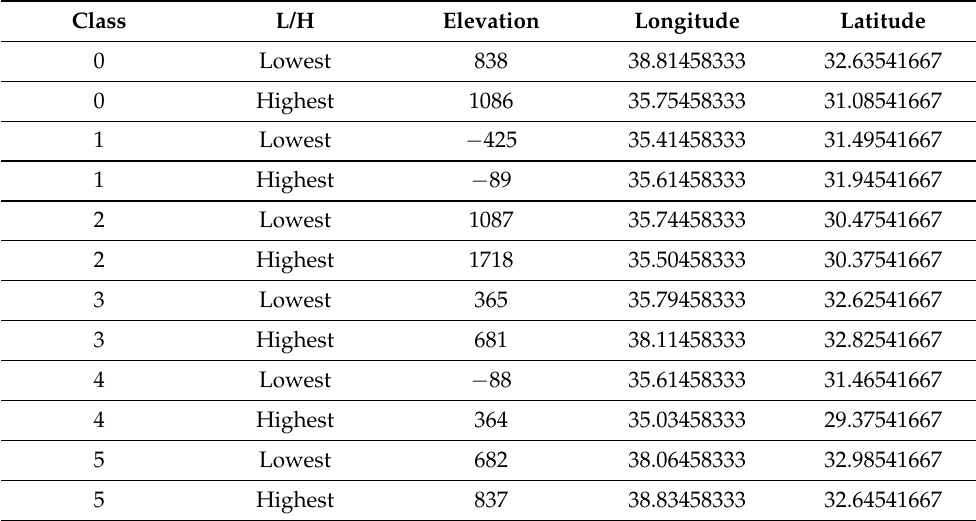
Table 6. Elevation—lowest and highest value–longitude and latitude in each cluster with K =